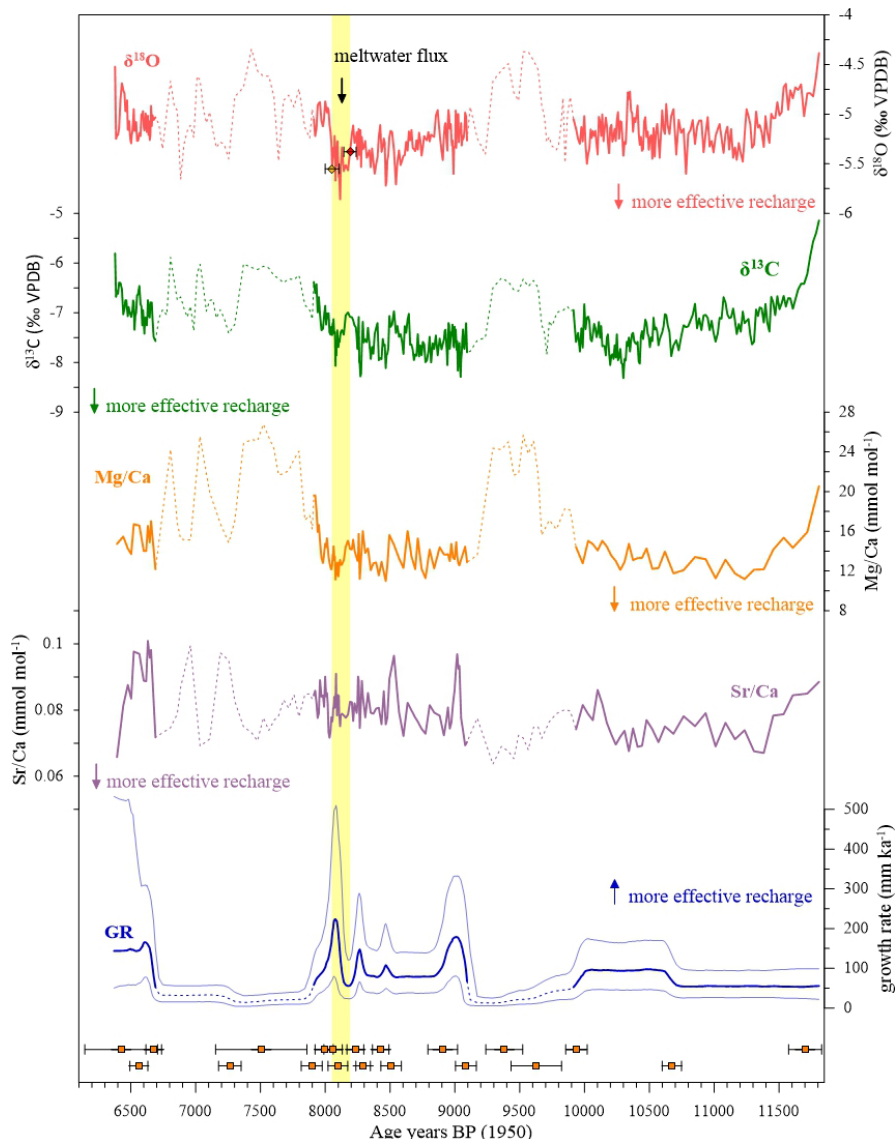
Figure 4. SIR-14 proxy time series. From top: δ 18 O, δ 13 C, Mg / Ca, Sr / Ca, growth rate and U–Th dates (2 σ uncertainties). The likely posi- tion and duration of the 8.2ka event are determined from the excursion in the δ 18 O signal indicated by the yellow shading. See Sect. 5.2.1 for further explanation of the determination for onset and end of the event. The two intervals of relatively low growth rates (GRs < 50mmkyr − 1 ) are indicated by dotted lines. The variability through these intervals is interpreted to be related to effects specific to the drip site and unrelated to regional climate changes. The growth-rate uncertainties (1 σ ) are plotted as light blue lines and are derived from the uncertainties in the age